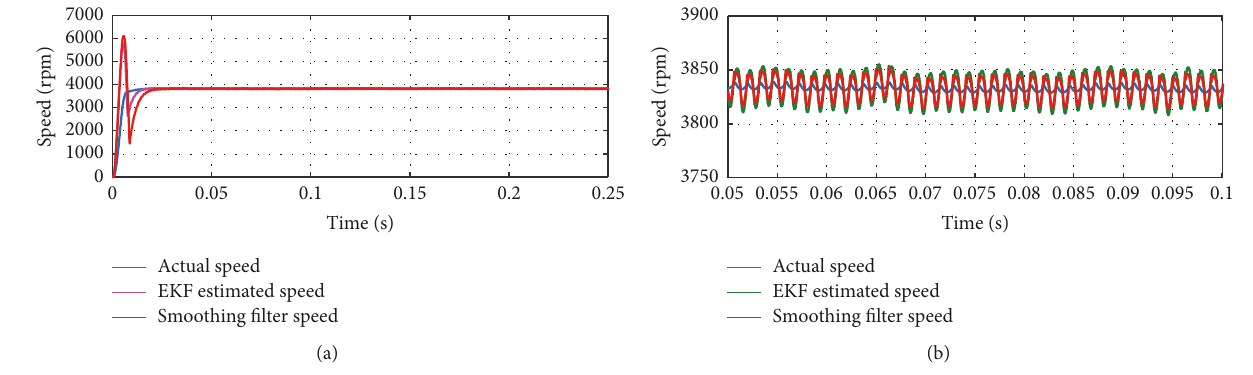
Figure 6: (a) Estimated and actual rotor speed at 𝑇 𝑙 = 0.45 Nm. (b) Zoomed view of the speed